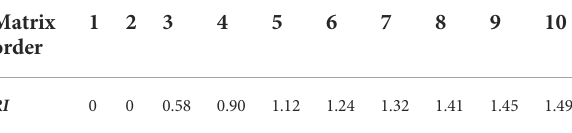
TABLE 3 RI value of average random consistency